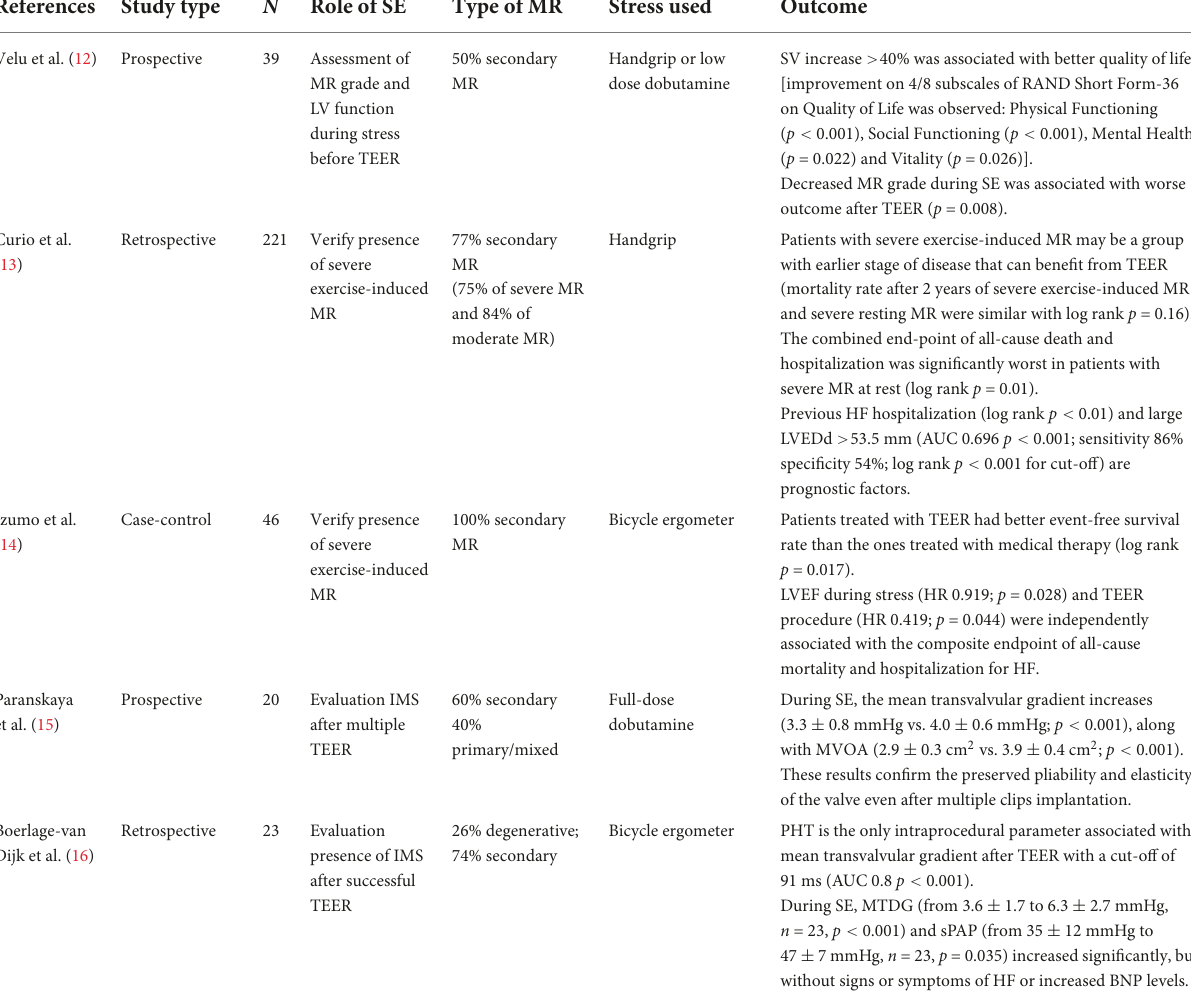
TABLE 1 Studies on SE in candidates for